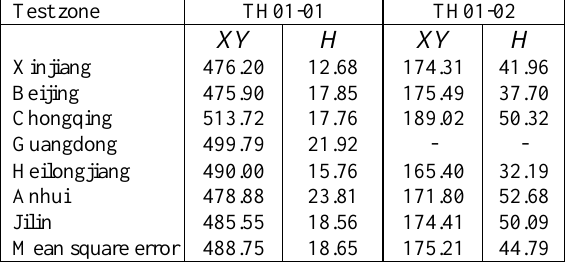
Table 3. Postioning accuracy of seven calibration fields before the calibration （ X , Y ： Gauss-Krueger Projection ， H ： Geodetic height ， Unit ： m ）